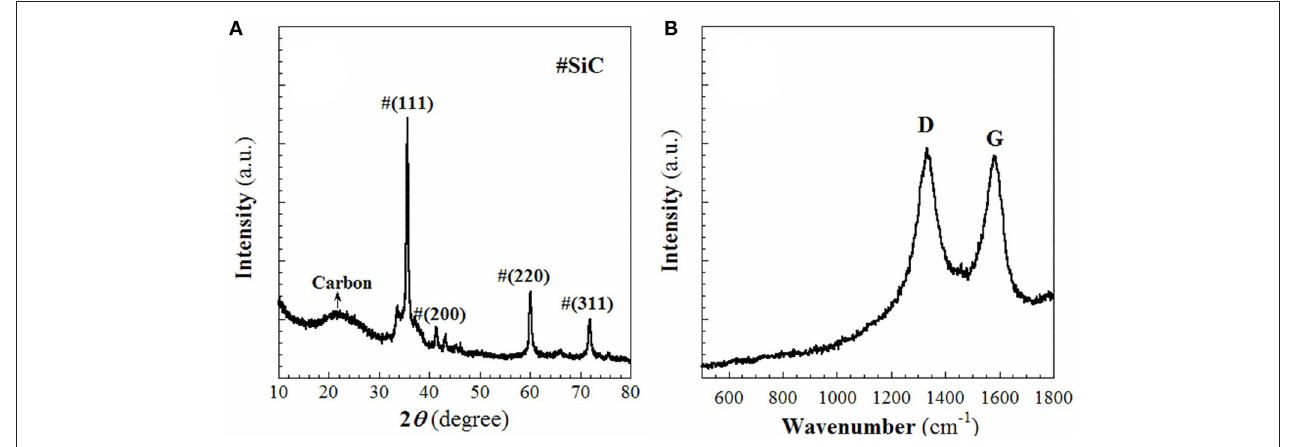
FIGURE 1 | (A) WAXRD pattern and (B) Raman spectrum of the sample S2 .